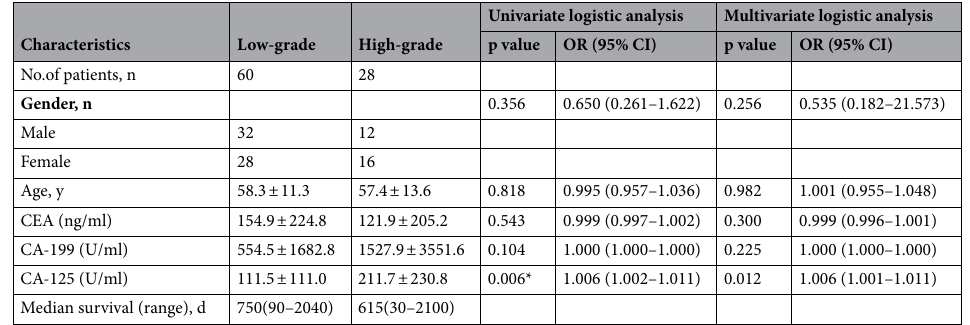
Table 1. Characteristics of all patients and logistic analysis results of clinical factors.